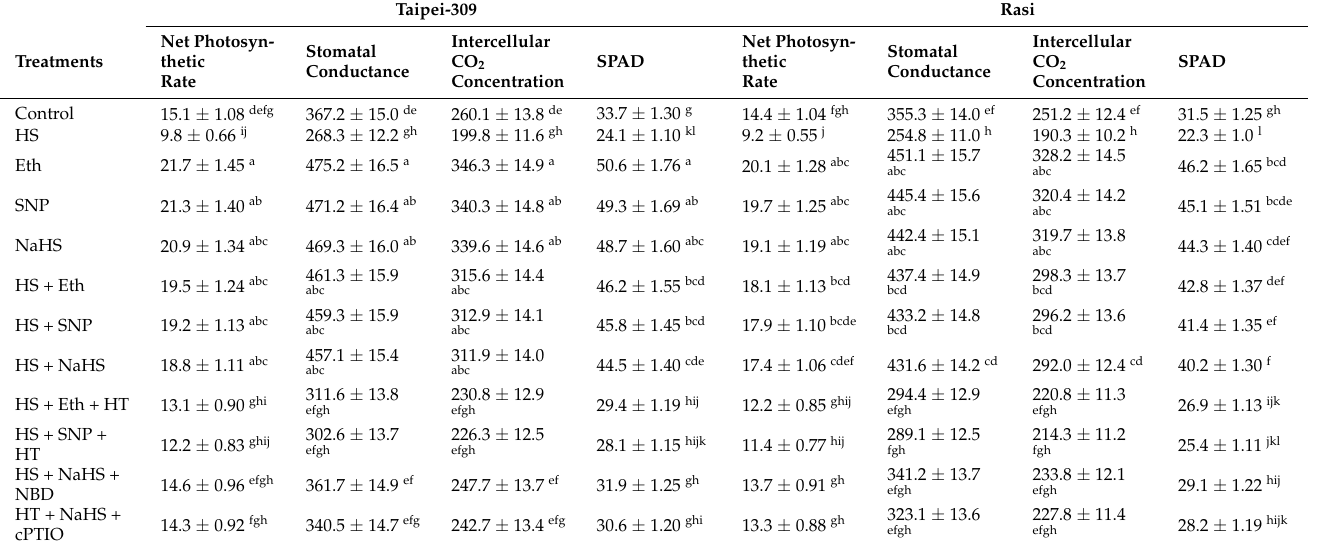
Table 1. Net photosynthetic rate ( µ mol CO 2 m − 2 s − 1 ), stomatal conductance (mmol m − 2 s − 1 ), intercel- lular CO 2 concentration ( µ mol mol − 1 ), and chlorophyll content (SPAD value) of rice ( Oryza sativa L.) cultivars Taipei-309 and Rasi after foliar treatment of plants with 200 µ L L − 1 ethephon (Eth), 100 µ M sodium nitroprusside (SNP) or 200 µ M sodium hydrosulfide (NaHS) grown with or without high temperature stress (HS; 40 ◦ C) or 100 µ M hypotaurine (HT), 100 µ M 2-4-carboxyphenyl-4,4,5,5- tetramethylimidazoline-1-oxyl-3-oxide (cPTIO) or 100 µ M norbornadiene (NBD) scavengers of hydro- gen sulfide (H 2 S), nitric oxide (NO), and ethylene action inhibitors, respectively, with HS at 15 days after sowing. Data are presented as treatments mean ± SE ( n = 4). The values followed by the same letters did not differ significantly by LSD test at p <